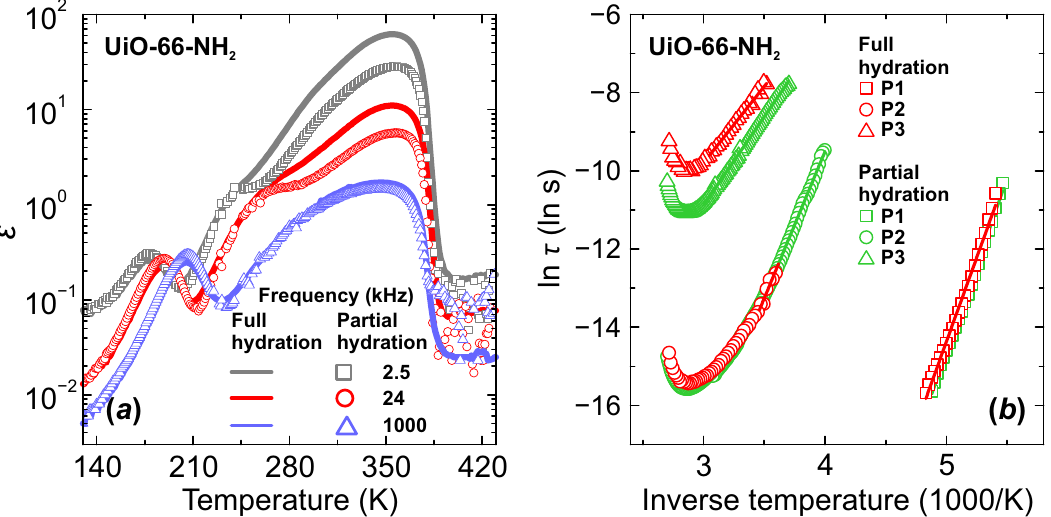
Figure 6. Temperature dependence of the ( a ) imaginary part of the complex dielectric permittivity and ( b ) mean relaxation time of fully and partially hydrated UiO-66-NH